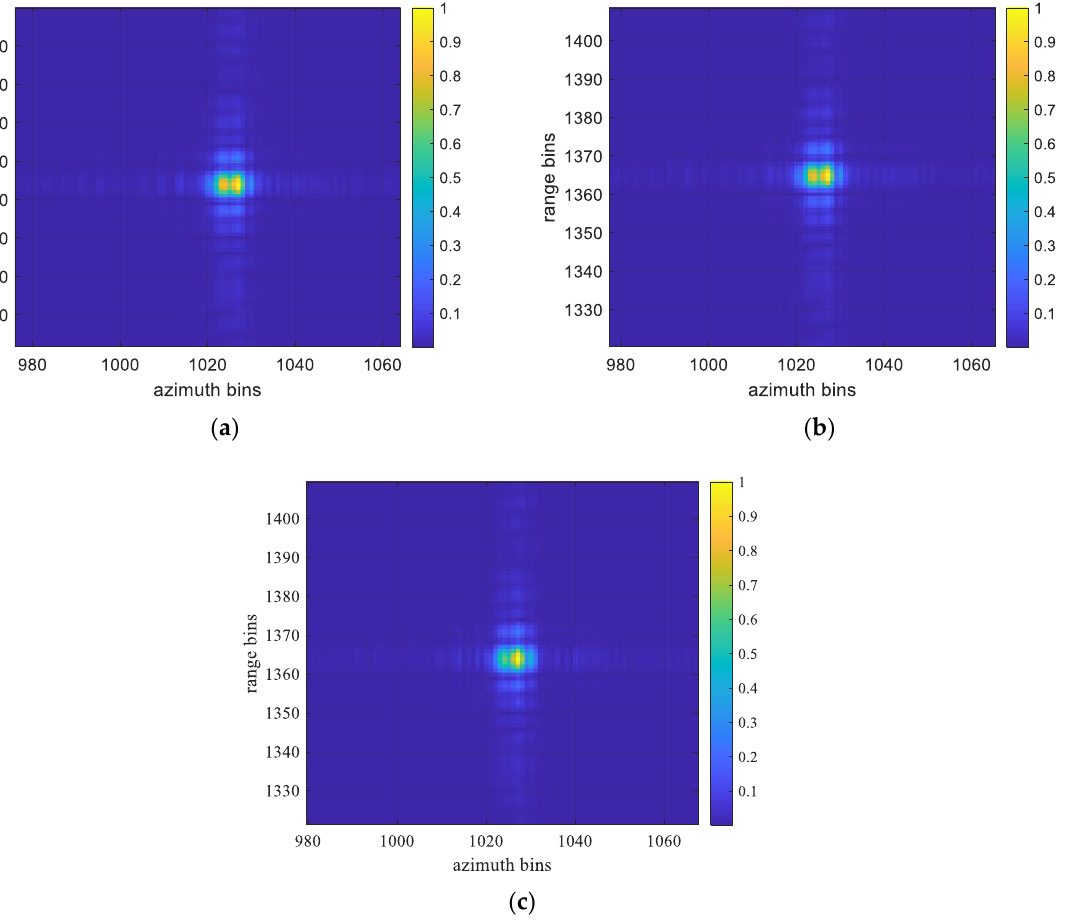
Figure 7. The imaging results of corner reflectors with different algorithms: ( a ) FP-MEA; ( b ) N-MEA; ( c ) DN-MEA.